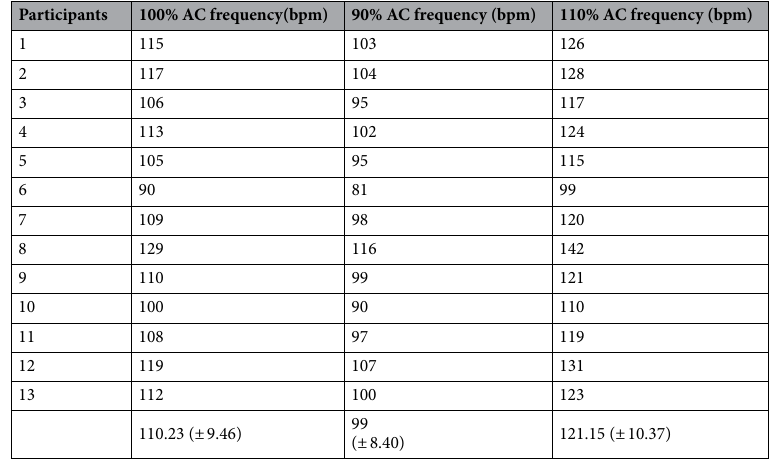
Table 2. Frequencies based on average cadence of each participant measured in beats per minute (mean ± standard deviation). The 100%AC is the frequency equal to the average cadence of each participant. The 90% AC is the frequency equal to 90% of the participants’ cadence. The 110% AC is the frequency equal to 110% of the participants’